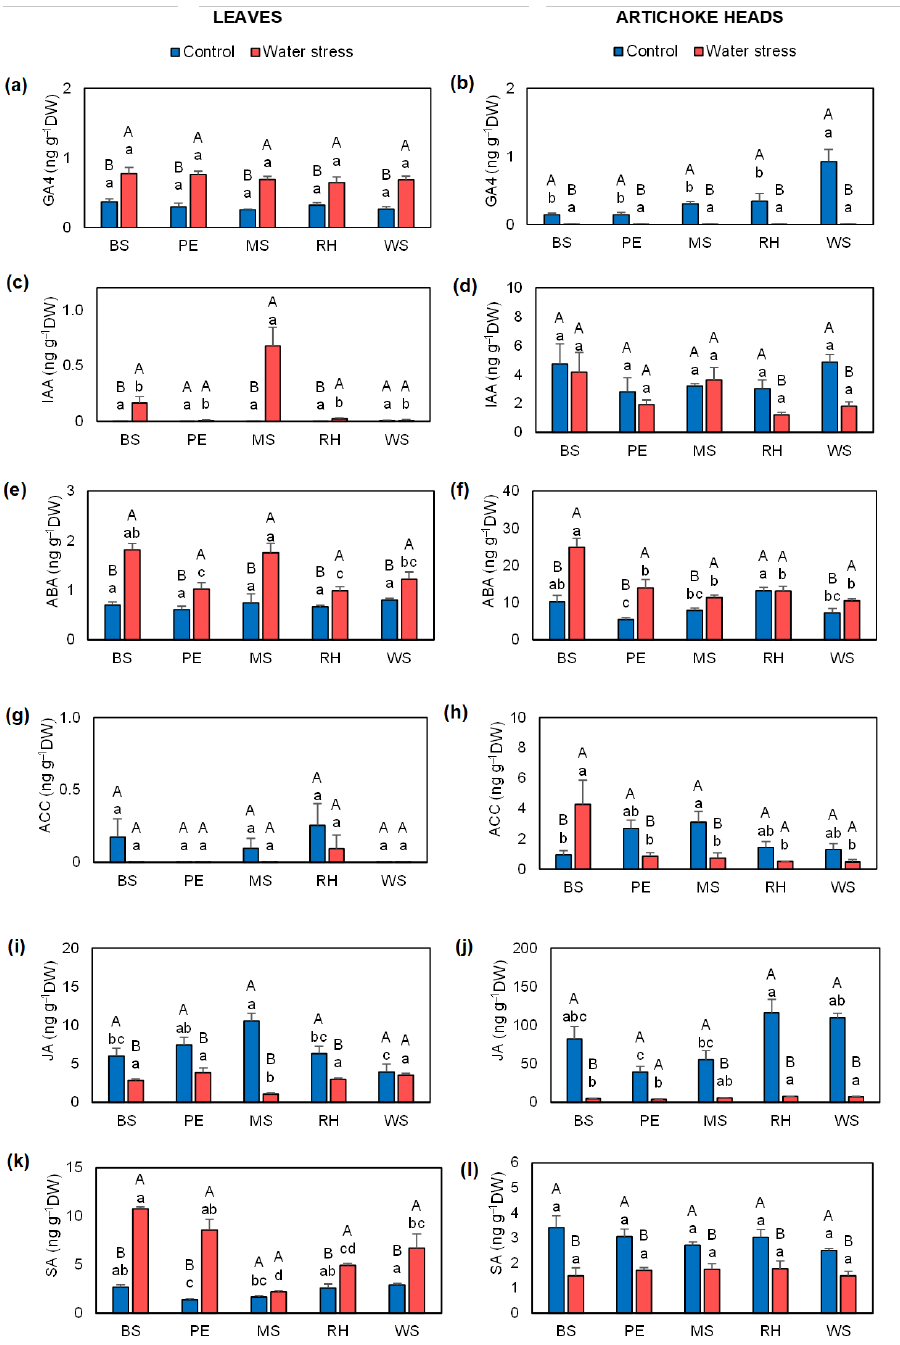
Figure 5. ( a , b ) Gibberellin A4 (GA4), ( c , d ) indoleacetic acid (IAA), ( e , f ) abscisic acid (ABA), ( g , h ) 1- aminocyclopropane-1-carboxylic acid (ACC), ( i , j ) jasmonic acid (JA) and ( k , l ) salicylic acid (SA) in leaves and heads of artichoke plants of the commercial Symphony variety non-mulched or subjected to different mulching treatments and cultivated under control (well-watered) and water-stress (70% ETc) conditions. Bars show the means of five plants ± standard error. Different capital letters indicate significant differences due to the water-stress treatment, while different small letters show significant differences among mulching treatments according to Tukey’s test ( p ≤ 0.05). Abbreviations used: bare soil (BS), polyethylene mulch (PE), mushroom-substrate-based hydromulch (MS), rice-hull-based hydromulch (RH), and wheat-straw-based hydromulch (WS).